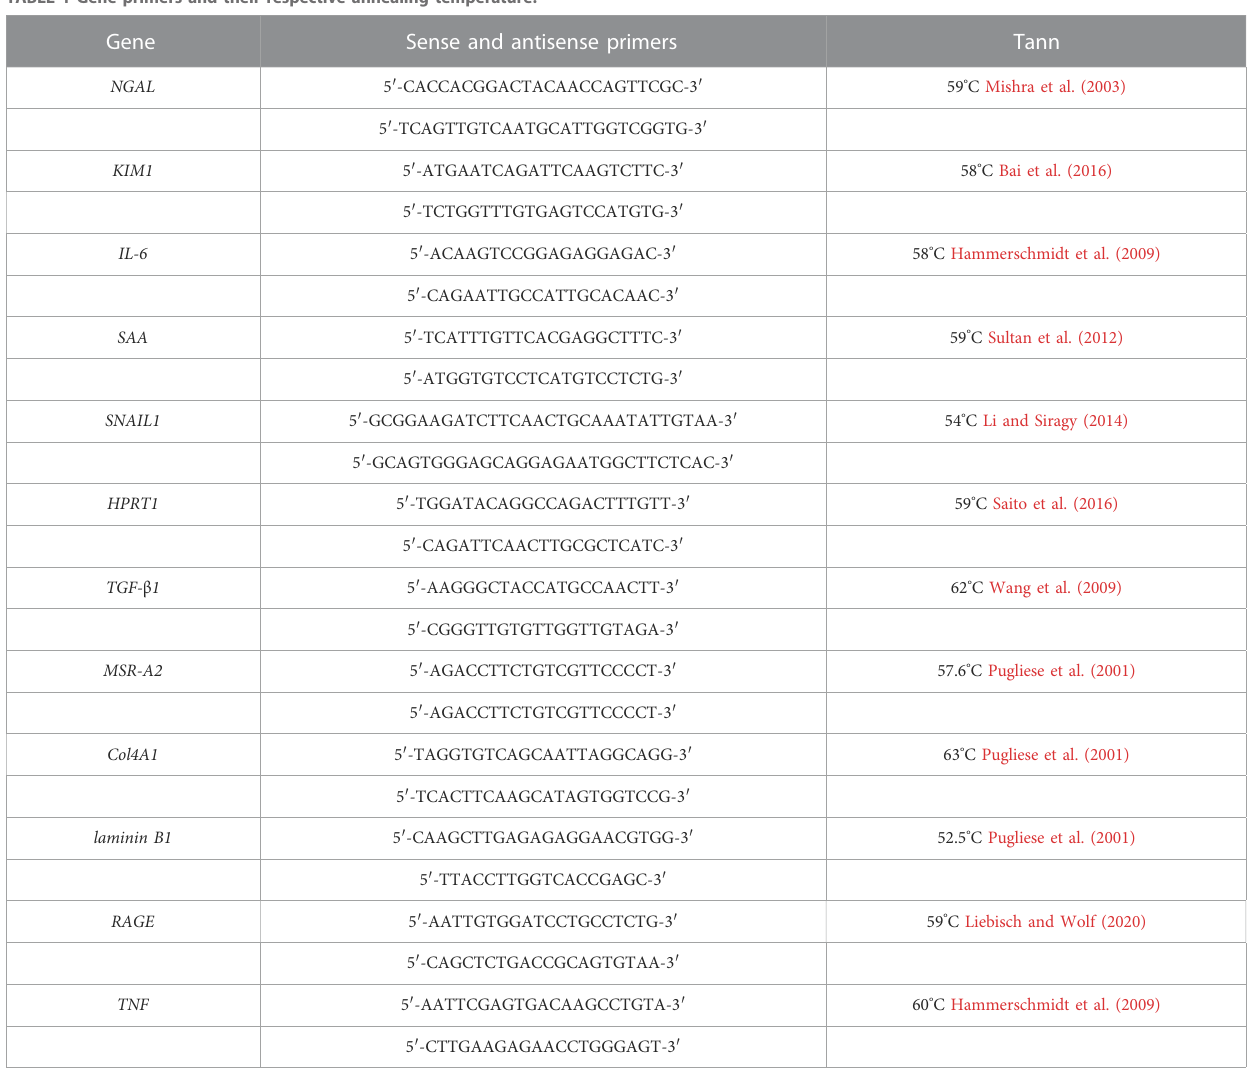
TABLE 1 Gene primers and their respective annealing temperature. Gene Sense and antisense